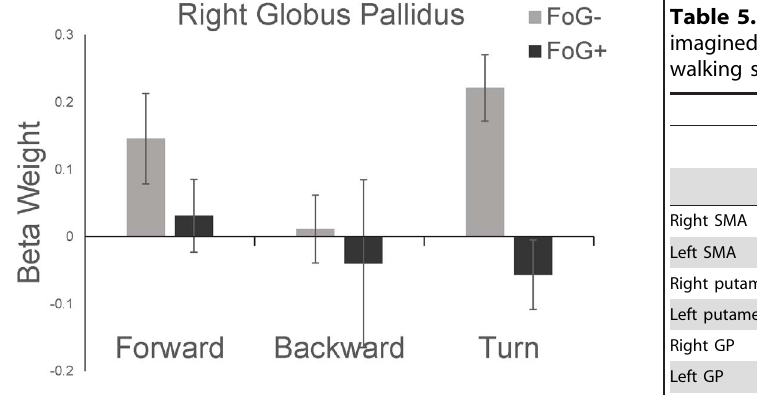
Figure 5. Mean Beta weights (with respect to rest) for FoG- and FoG + during imagined walking in the right GP. A group effect, corrected for MDS-UPDRS and gait imagery speed, was noted such that FoG + exhibited smaller BOLD signal than FoG- (p=0.01). Error bars represent standard error of the mean.